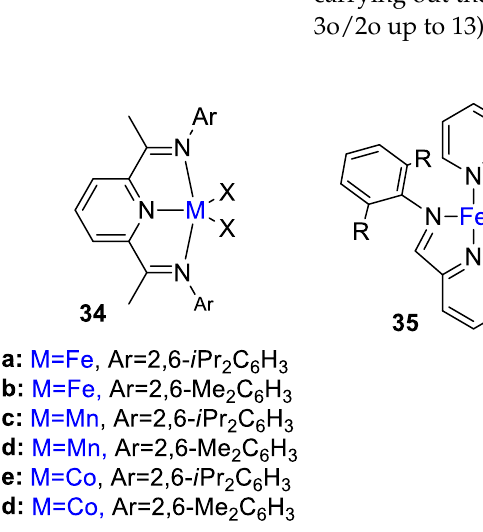
Figure 7. Selected imine-based iron complexes.